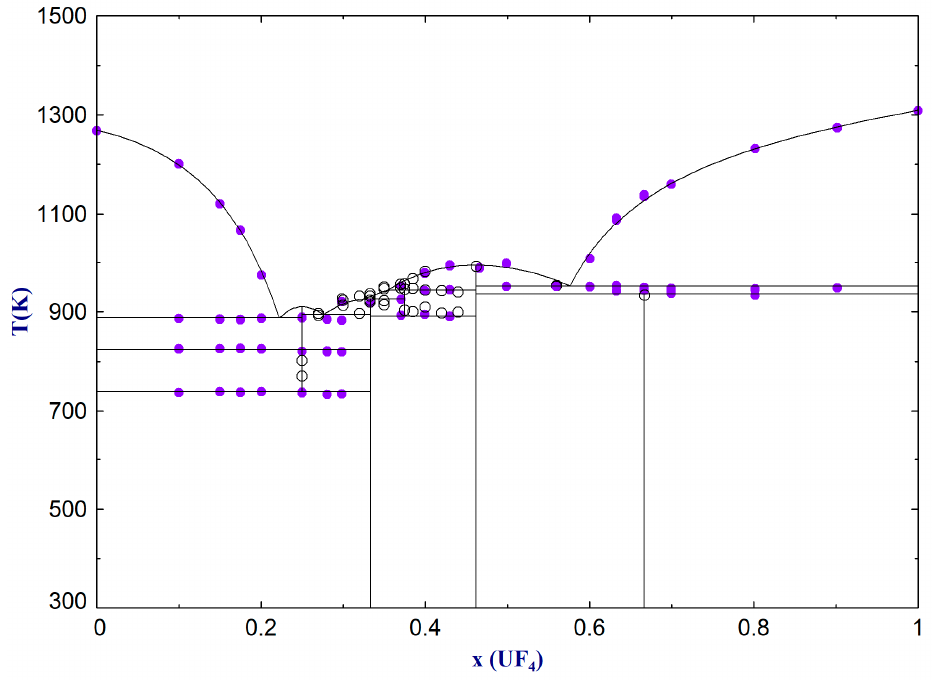
Figure 2. The calculated NaF-UF 4 phase diagram superimposed with our experimental data (purple solid circles) and experimental data from Barton et al. [15] (hollow circles).